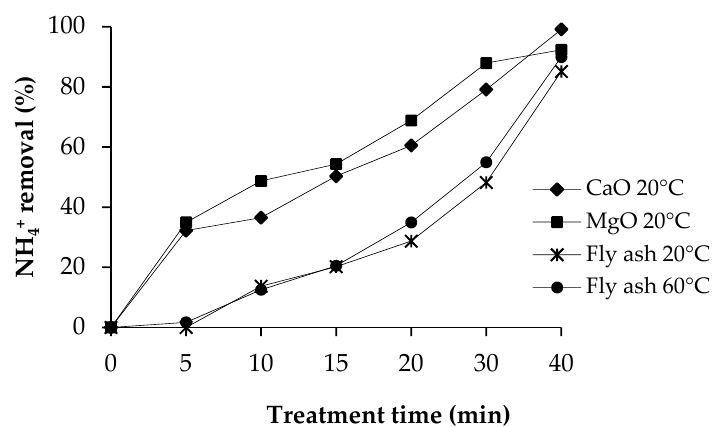
Figure 3. Ammonium removal percentage of different precipitants, and temperature.